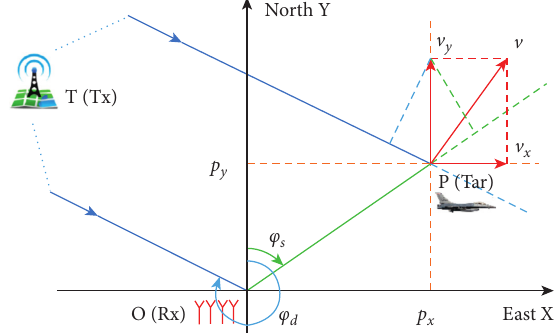
Figure 6: Radio wave propagation